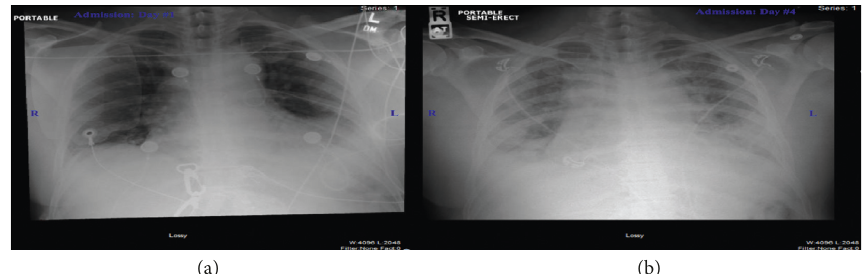
Figure 1: Portable chest radiography. (a) Defibrillator pad over the right chest wall. The lung is clear with sharp costophrenic angles bilaterally. Mild subsegmental atelectasis at the lung bases is seen. There are no airspace infiltrates, focal consolidation, pleural effusion, or pneumothorax. (b) Enlarged cardiomediastinal silhouette. Interval development of small bilateral pleural effusions and pulmonary congestion occurs.